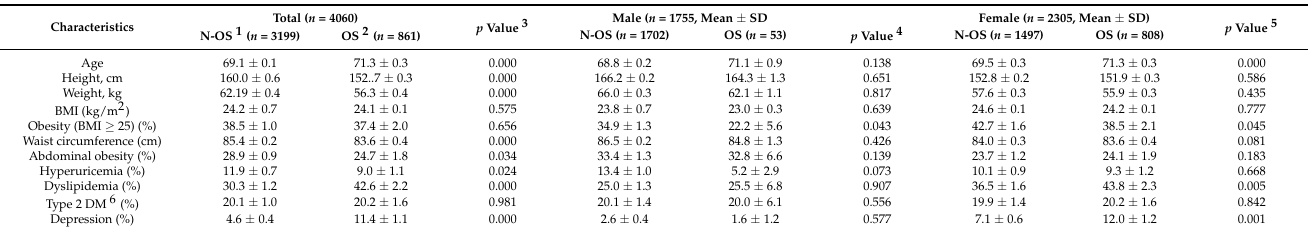
female subjects. Concerning the presence of osteoporosis, obesity, T2DM, and BMI were not significant between subjects with and without osteoporosis (Table 1). Table 1. Overall characteristics and comparison of total subjects, male subjects and female subjects with or without osteoporosis. Characteristics